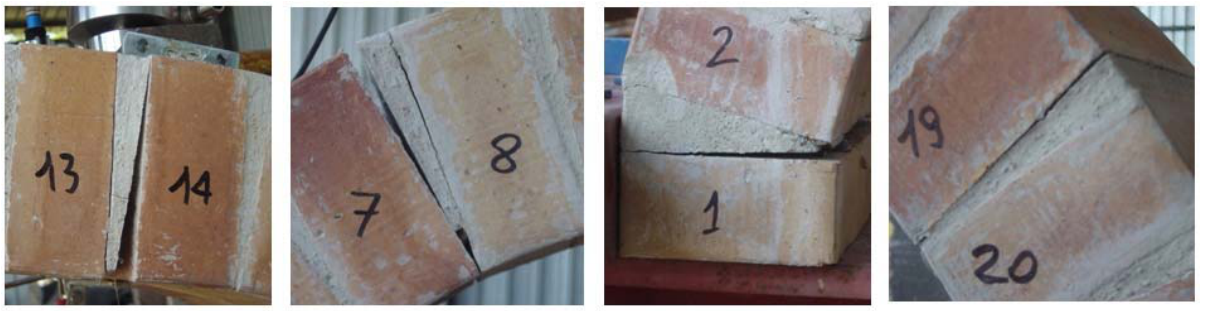
Figura 11: Immagini delle posizione delle cerniere dell’arco.